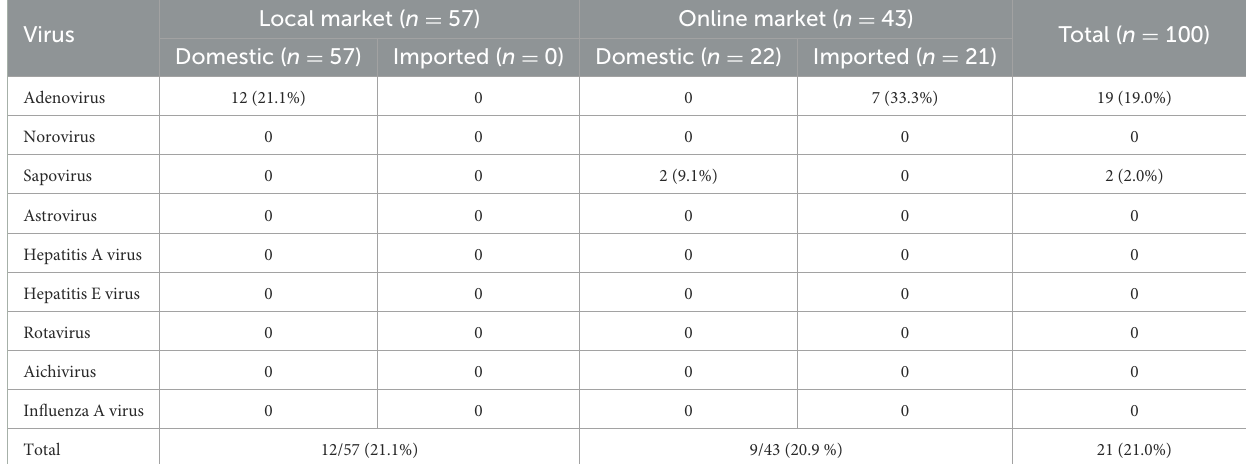
TABLE 4 The detection rate of foodborne viruses and influenza A virus in chicken samples.